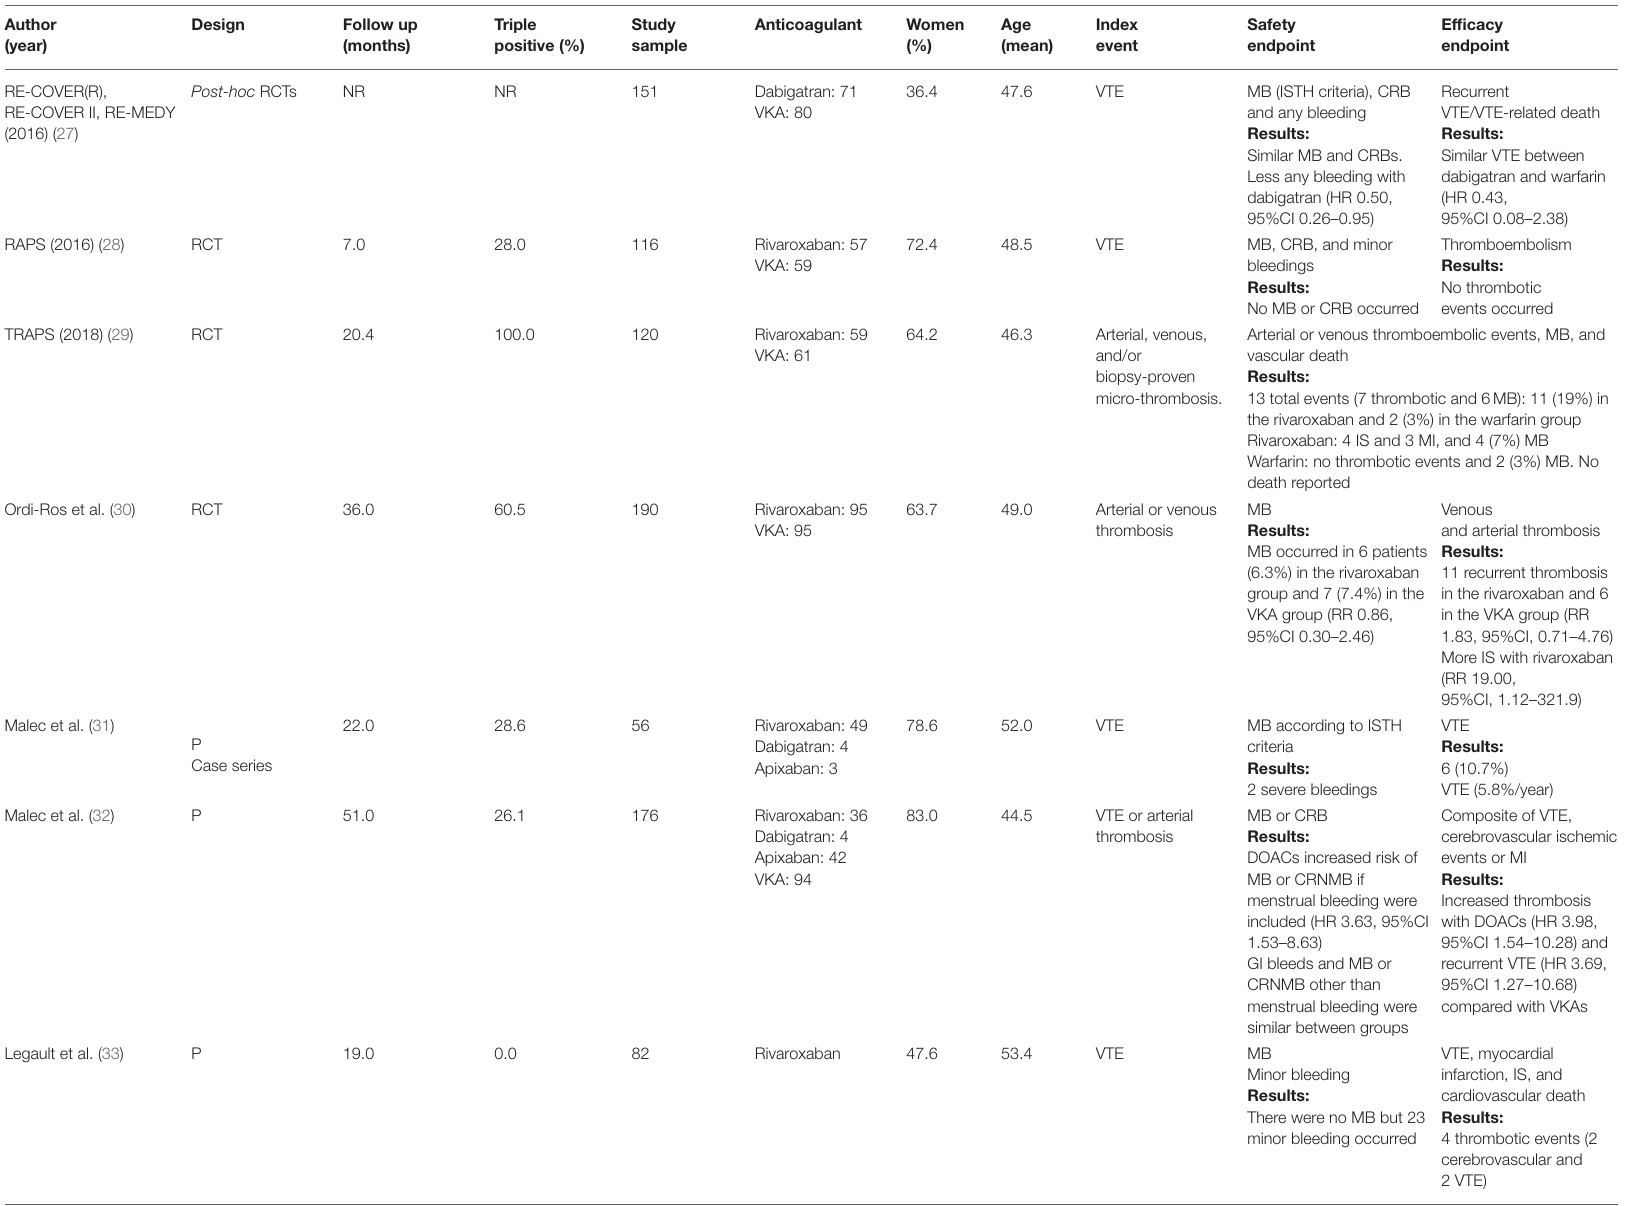
TABLE 2 | Characteristics of studies enrolling patients with APS treated with DOACs. Author